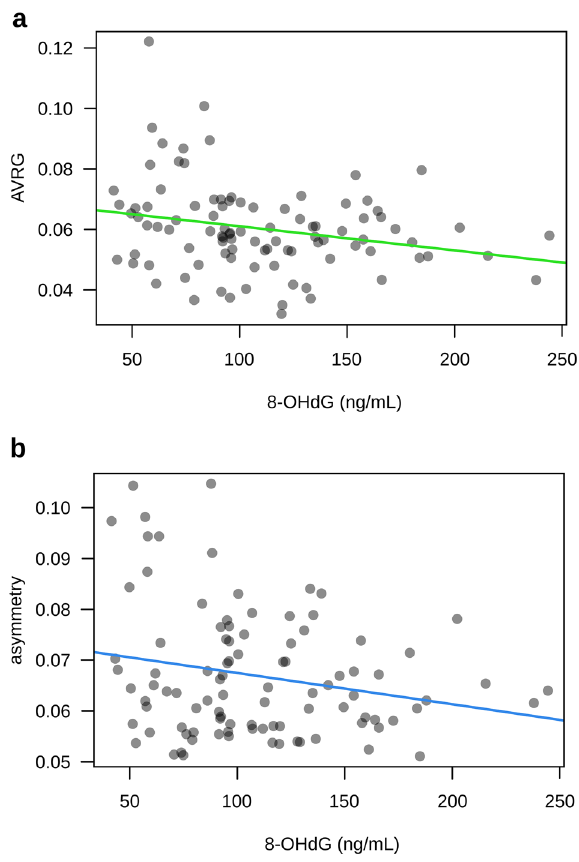
Figure 2. Scatter plots of the relation between 8-OHdG and ( a ) averageness (AVRG) and ( b ) facial asymmetry with a plotted regression